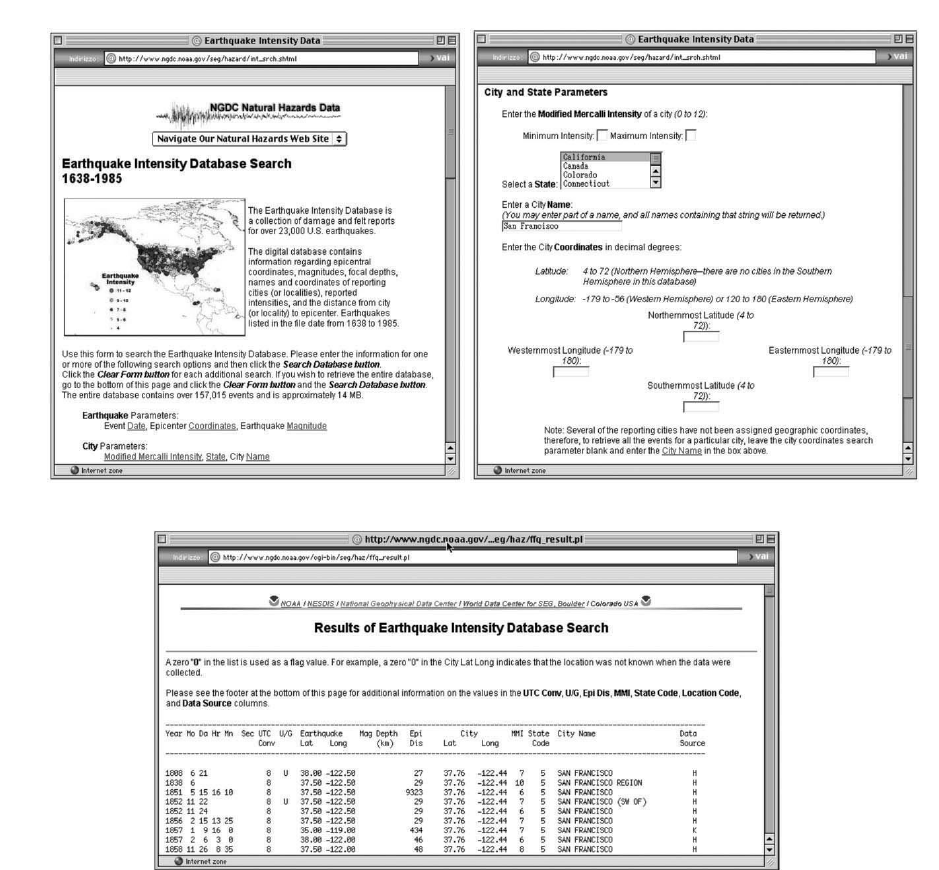
Fig. 5. US Intensity Database: main page, query by city and state parameters and related